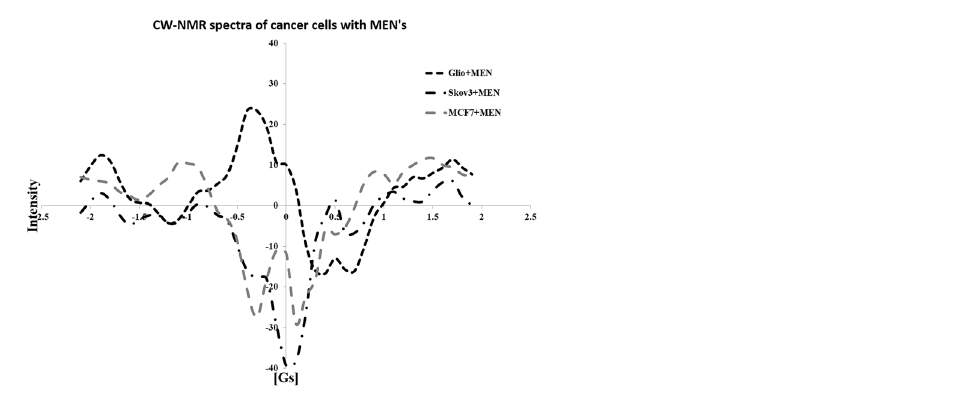
Figure 5. CW-NMR spectra of cell media with MENs for cancer